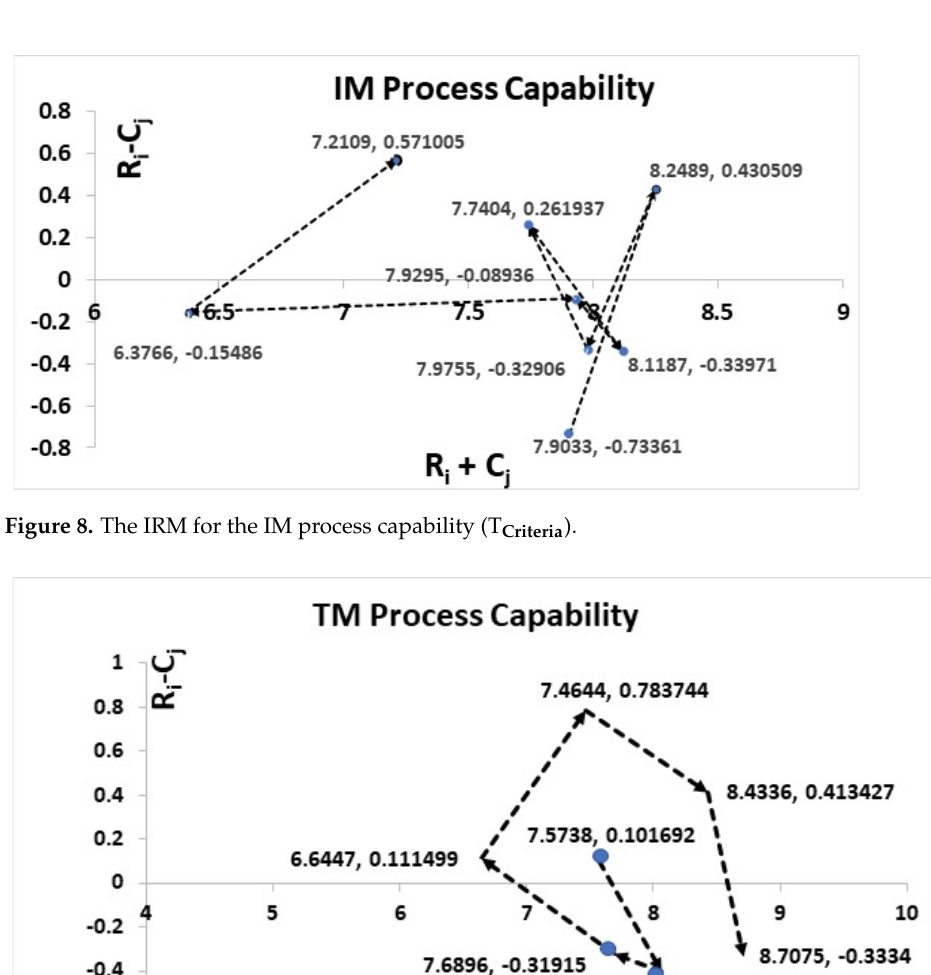
Figure 7. The IRM for the KM process capability (T Criteria ).